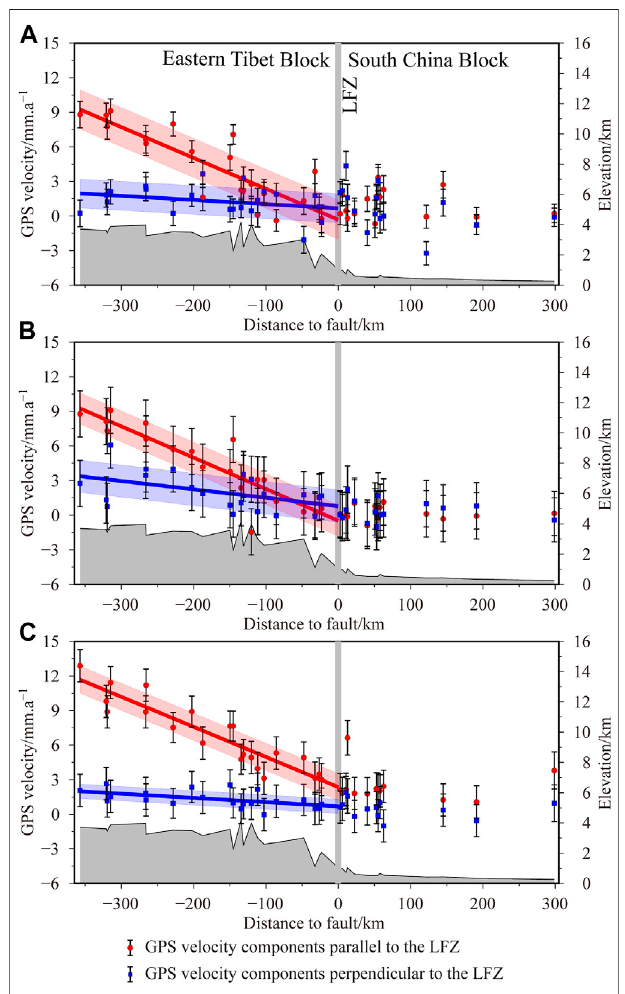
FIGURE 5| Global Positioning System (GPS) velocity pro fi les across the Longmenshan fault zone (LFZ) during (A) 1999 – 2001, (B) 2001 – 2004, and (C) 2004 – 2007. The topographic pro fi les are in each fi gure. The red lines and the blue lines are linear fi tting results of the dextral shear rates and compressive shortening rates in the Eastern Tibet Block with one standard deviation,